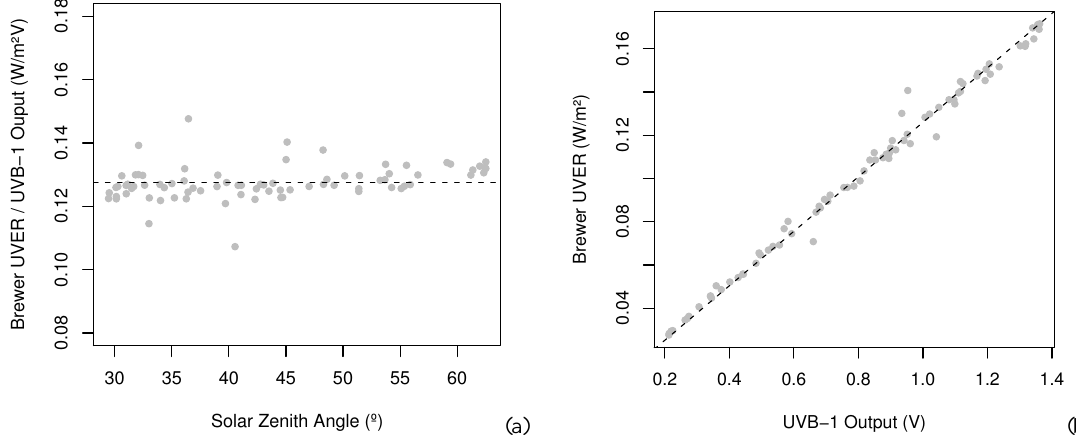
Fig. 2. (a) The ratio between the erythemally integrated irradiance given by the Brewer spectroradiometer and the YES UVB-1 radiometer output voltage as a function of the solar zenith angle during the Arenosillo’s campaign 2007. The horizontal line represents the mean ratio (0.1275Wm − 2 V − 1 ). (b) relationship between the Brewer erythemally integrated irradiance and the UVB-1 output voltage for SZA smaller than 65 ◦ together with the regression line corresponding to the first-order